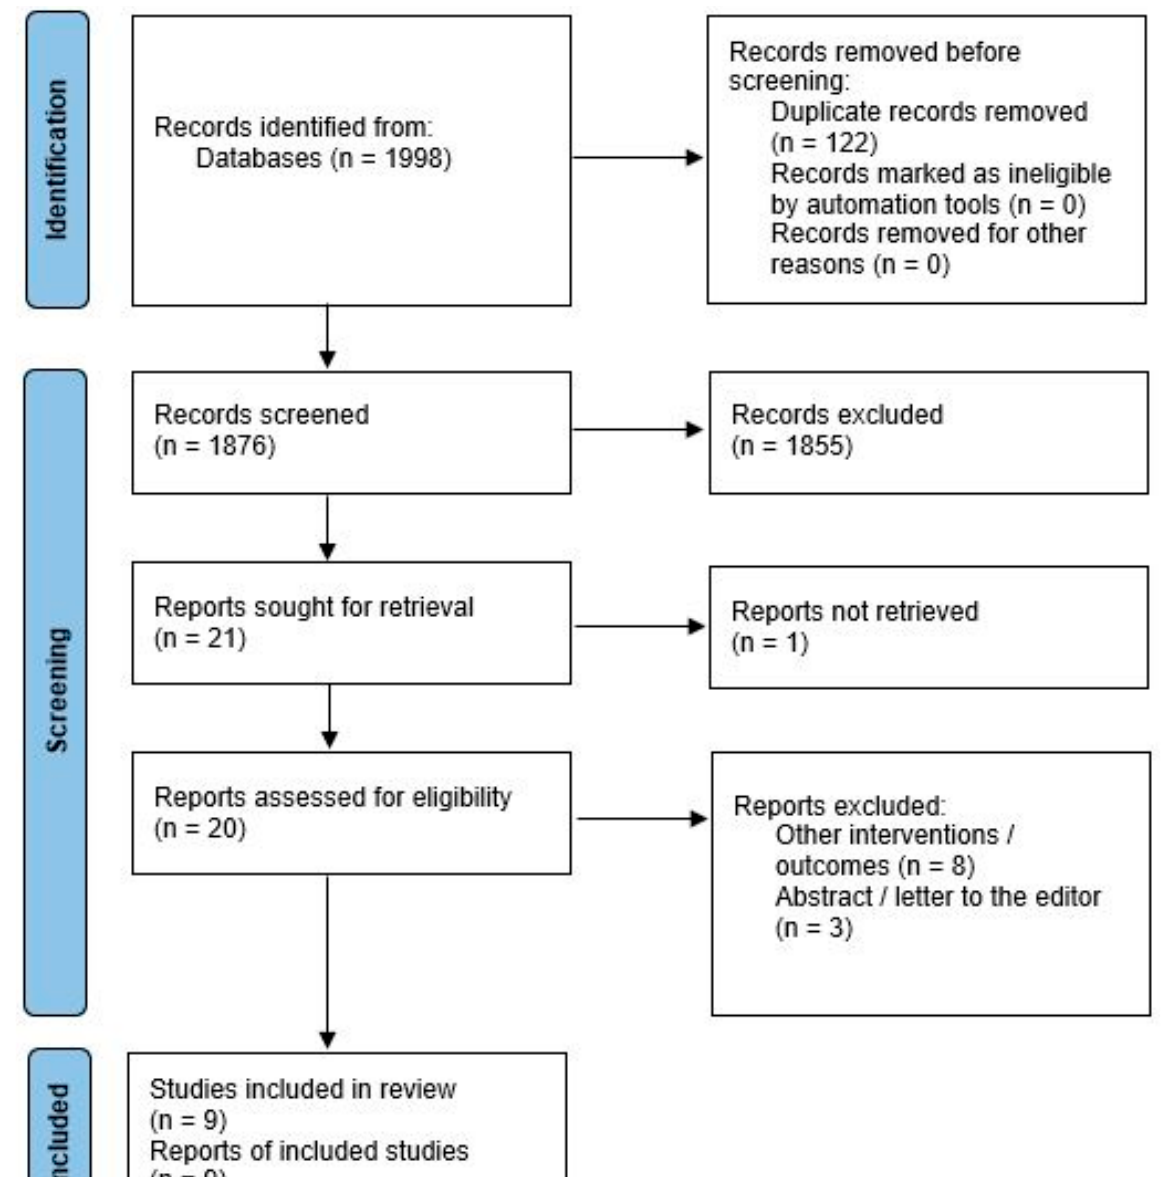
Figure 1. Study selection process.